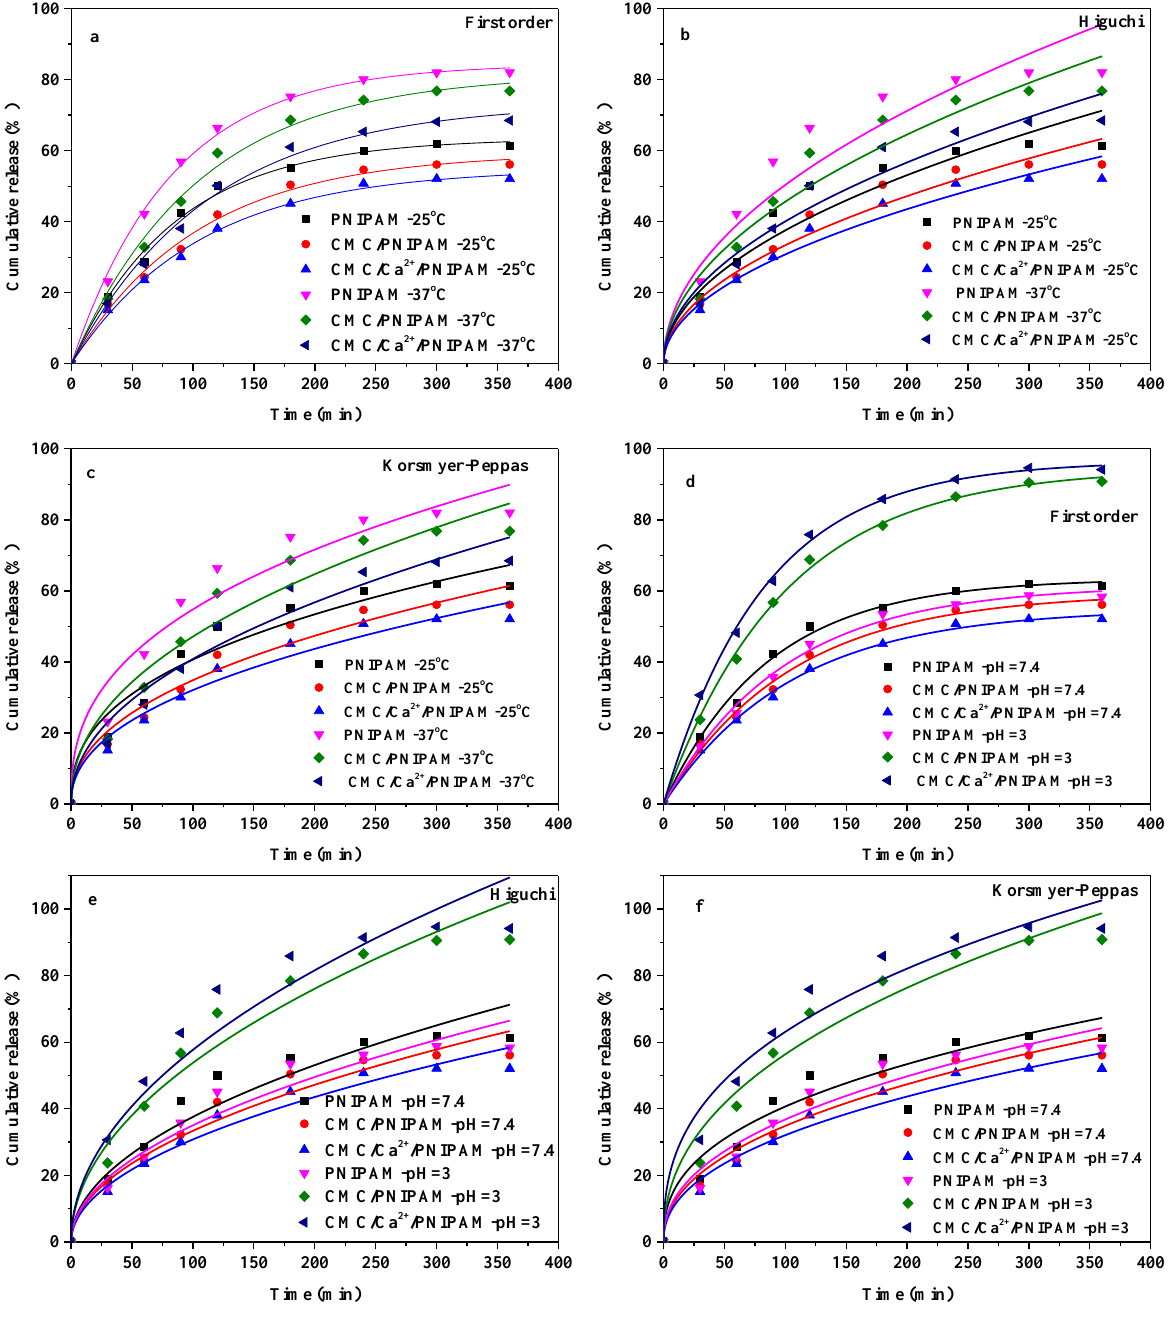
Figure 7. Fitting curve of drug release kinetics of aerogels. ( a – c ) are the First-Order, Higuchi and Korsmeyer–Peppas model of aerogels at different temperatures, respectively; ( d – f ) are the First-Order, Higuchi and Korsmeyer–Peppas model of aerogels at different pH.)